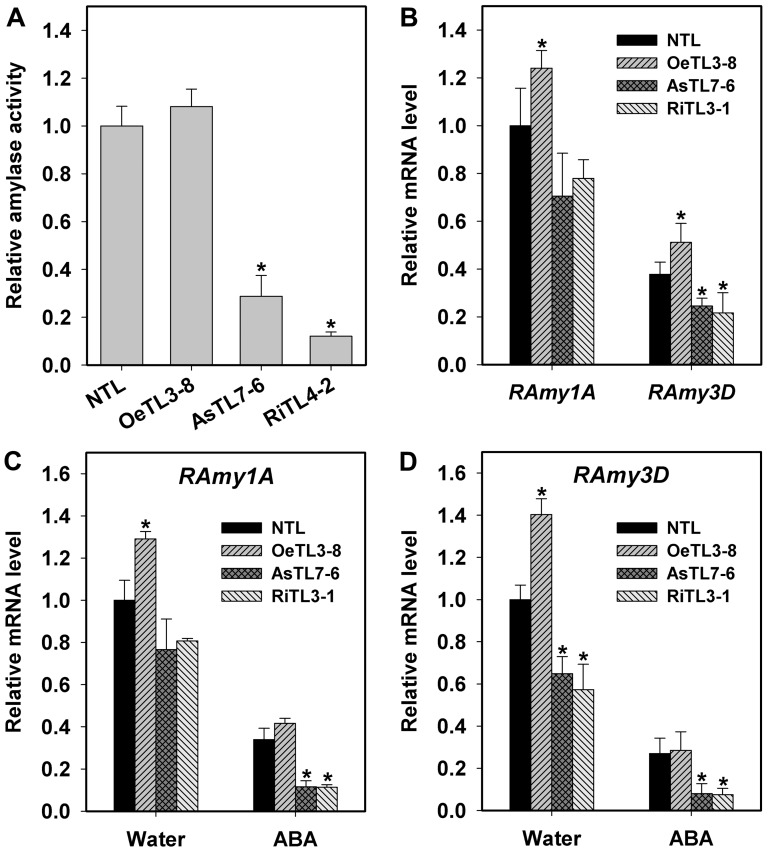
Comparisons of total amylase activity and of expression of two key amylase genes, RAmy1A and RAmy3D, in imbibed seeds of different transgenic lines and the effects of ABA.A, For amylase activity assay, frozen seeds (20 grains) were homogenized on ice and 100 µl aliquot of supernatant was taken into the assay after centrifugation. The reaction product was monitored using 3,5-dinitrosalicylic acid (DNS) method. B, C and D, Expressions of RAmy1A and RAmy3 were monitored in seeds of NTL, OeTL, AsTL and RiTL, respectively after 48h of imbibition in water or in ABA (20 µM). Relative expression levels were measured by qRT-PCR and normalized with respect to OsActin7 (LOC_Os11g06390). Results shown are means of three biological replications±SE. Asterisks (*) indicate significant difference (P<0.05) between the levels of expression of transgenic lines compared with the NTL.